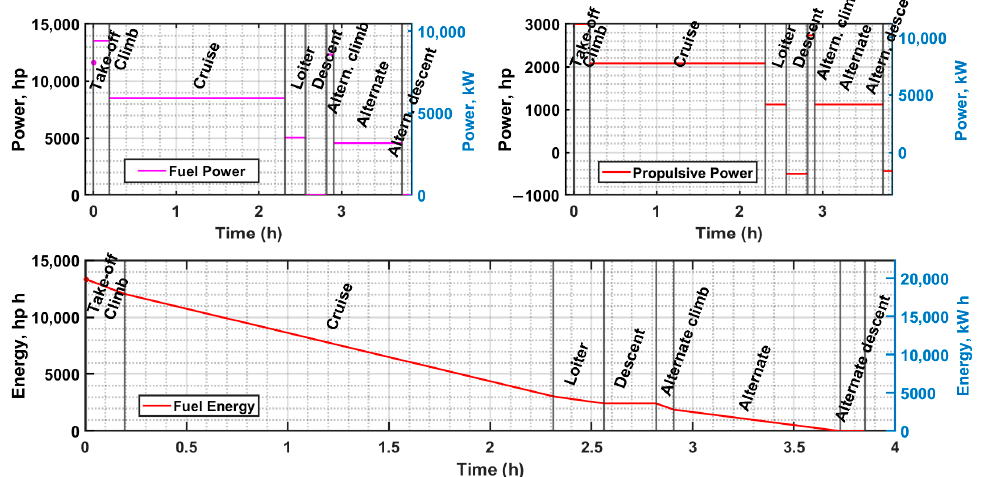
Figure 3. Simulation of Do-228NG power and energy required per flight segment.